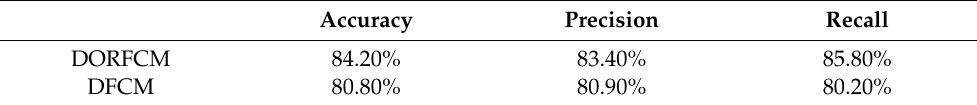
Table 2. Outlier effect performance comparison (91 cases).